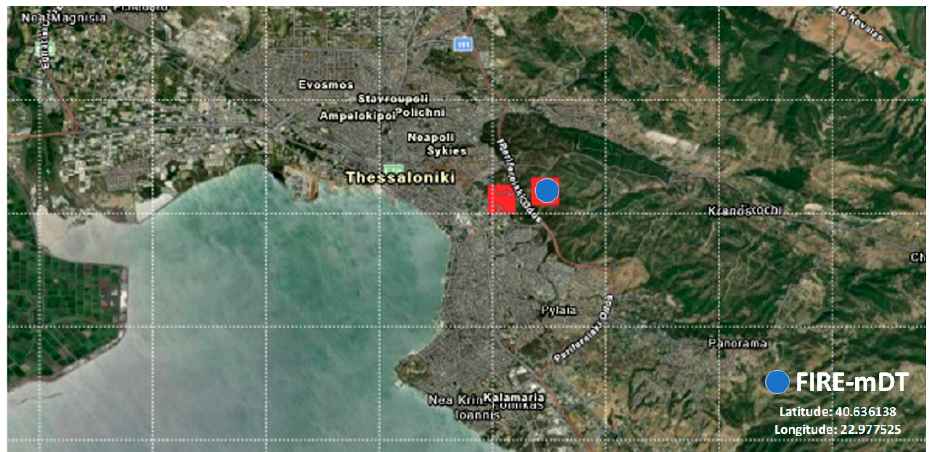
Figure 13. Fire data through MODIS (red boxes) and fire-mDT detected location (blue circle) for the fire incident on 13 July 2021.